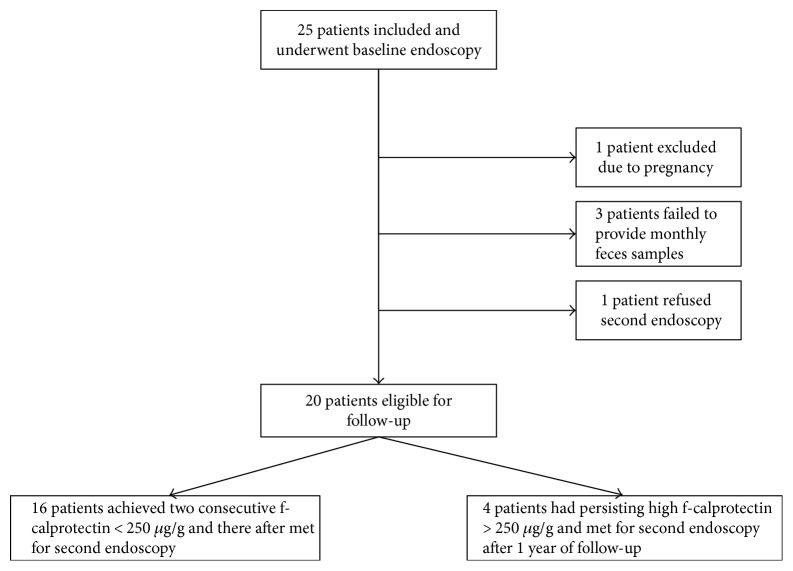
Flow chart of patients included in the study.